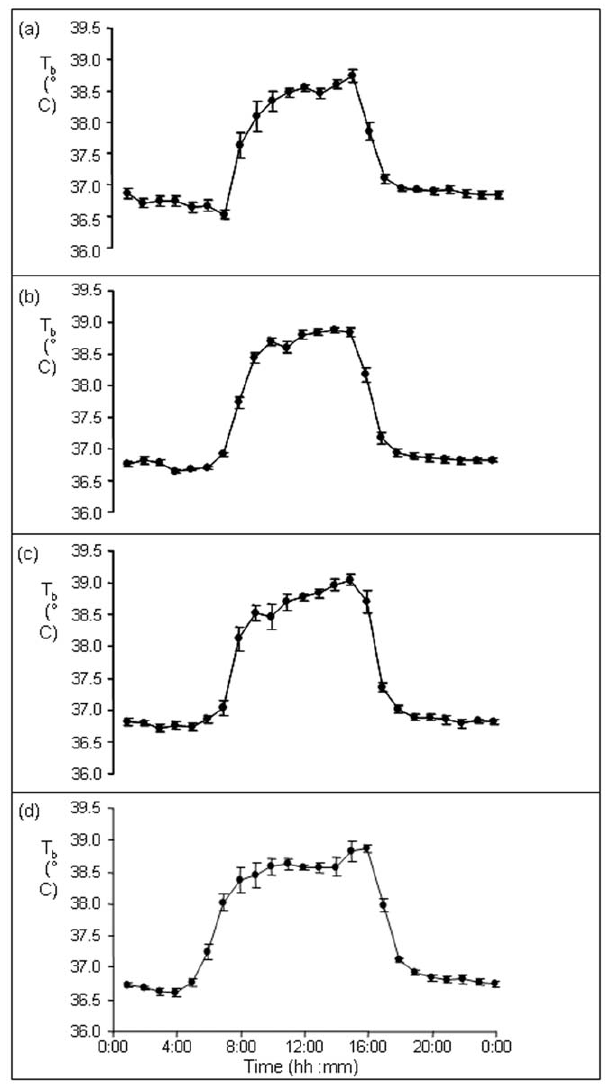
Figure 6. Mean ± SE T b of the eight individuals for the first, eighth, fifteenth and twenty-second weeks of the sampling period. T b values rose rapidly in the morning before reaching a plateau during the